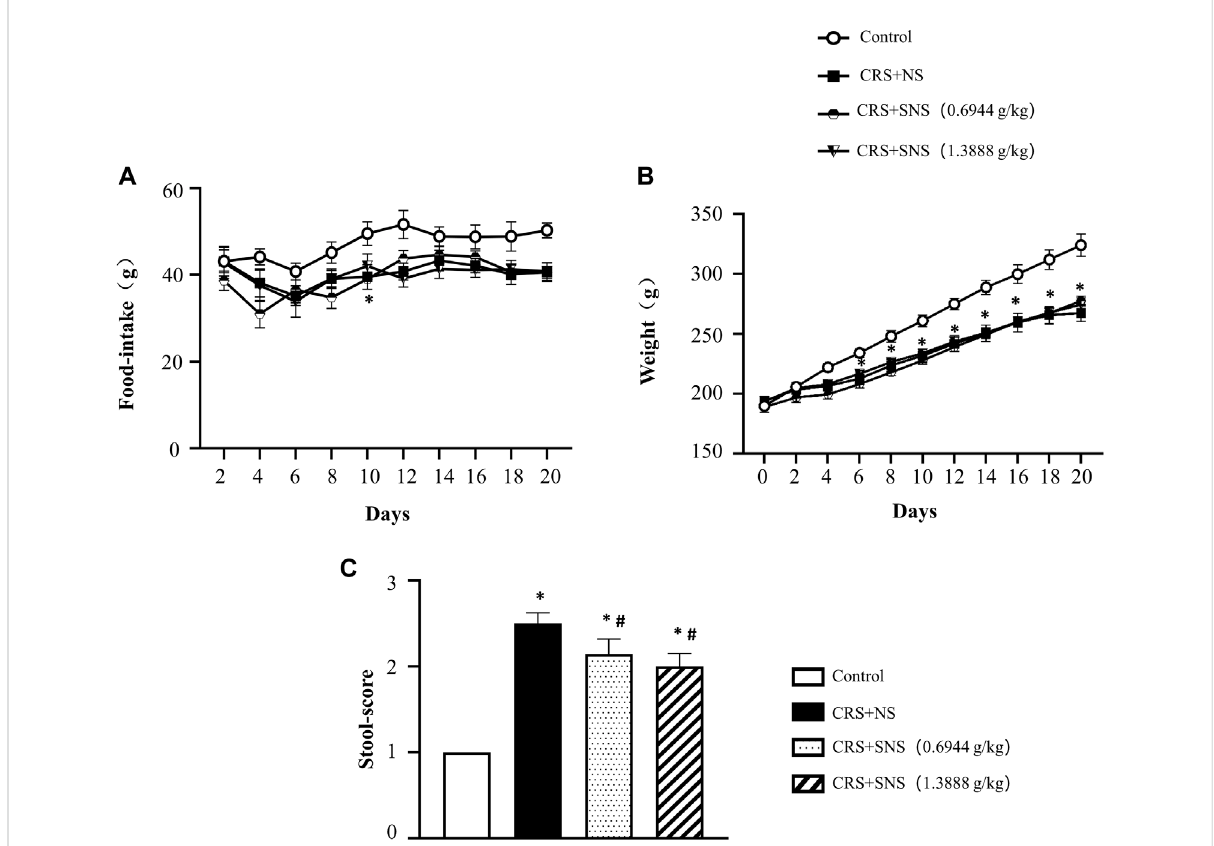
FIGURE 1 Effect of theSNS treatmenton rat weight, food-intake, and stools. (A) The changes inthe food-intake indifferent groups. F= 11.99. p < 0.0001. (B) Thechangesinthebodyweight indifferentgroups.F=1.967. p =0.1345. (C) Thefecalscore ofdifferentgroups.F=112.7. p < 0.0001.Results